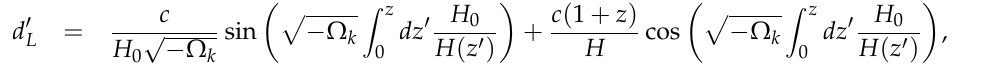
Figure 5. Top : Comparison between DE models: phantom and static domain walls and the O reconstructed using C-C+BAO data. The green dashed lines represent Equation (11) for a phantom ( w 0 < − 1) and static domain walls ( w 0 = − 2/3) models . The red solid lines represent the O diagnostic using the reconstructed h and h (cid:48) . We observe on the right-hand side plot that the static domain walls model appears to be more in agreement with the O comparison to the left plot where the phantom model starts to deviate from the O at low redshifts ( z < 0.5); Bottom : Probability comparison between DE models. The green bars represent DE models (phantom and static domain walls) and the red bars represent the amount of the reconstructed data. In addition, a 62% fraction of the reconstructed data lies in O in this range, we observe that the amount of O corresponds to 8% for a phantom model and 3% for a static domain wall. These probabilities support the results obtained